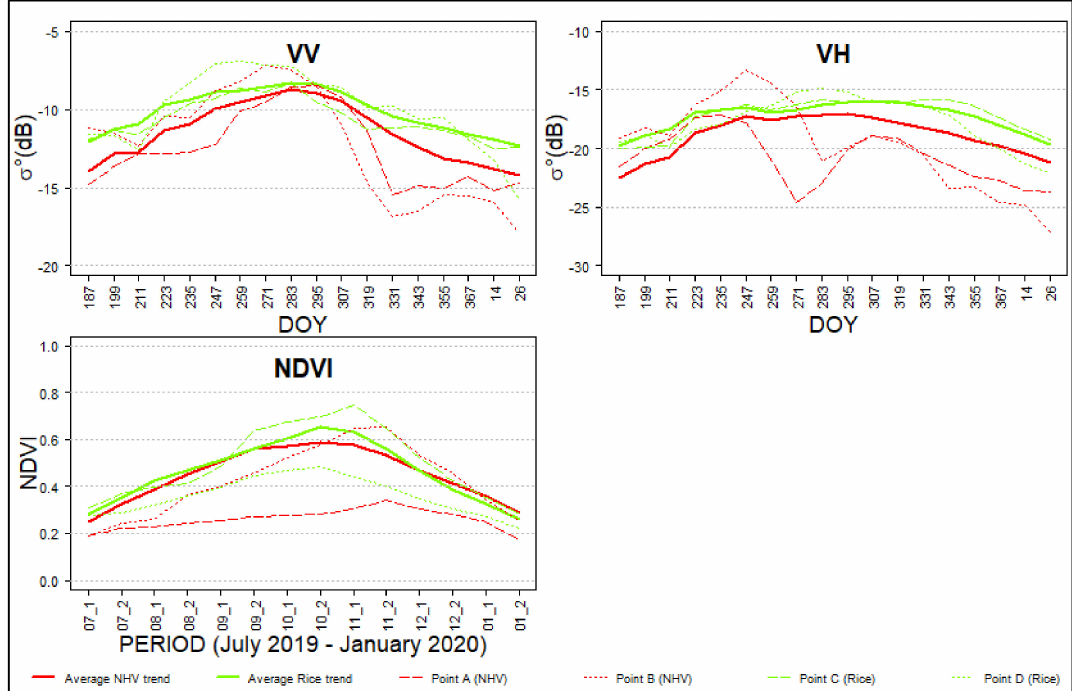
Figure 9. Average temporal patterns of NHV (Natural Herbaceous Vegetation) and Rice classes in 2019 against temporal patterns of four selected plots. (Point A: Lat. − 15.7788, Lon. 12.6201; Point B: Lat.